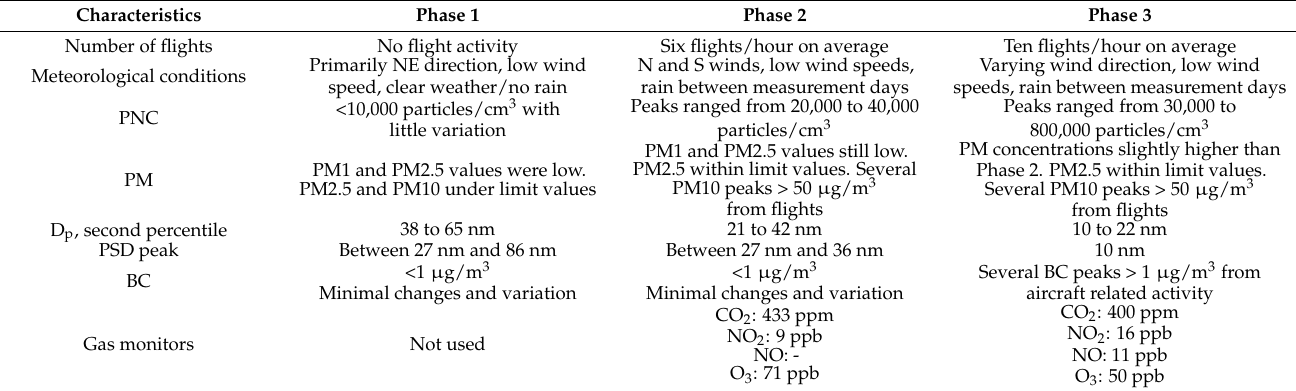
Table 3. Summary of measurements across all three